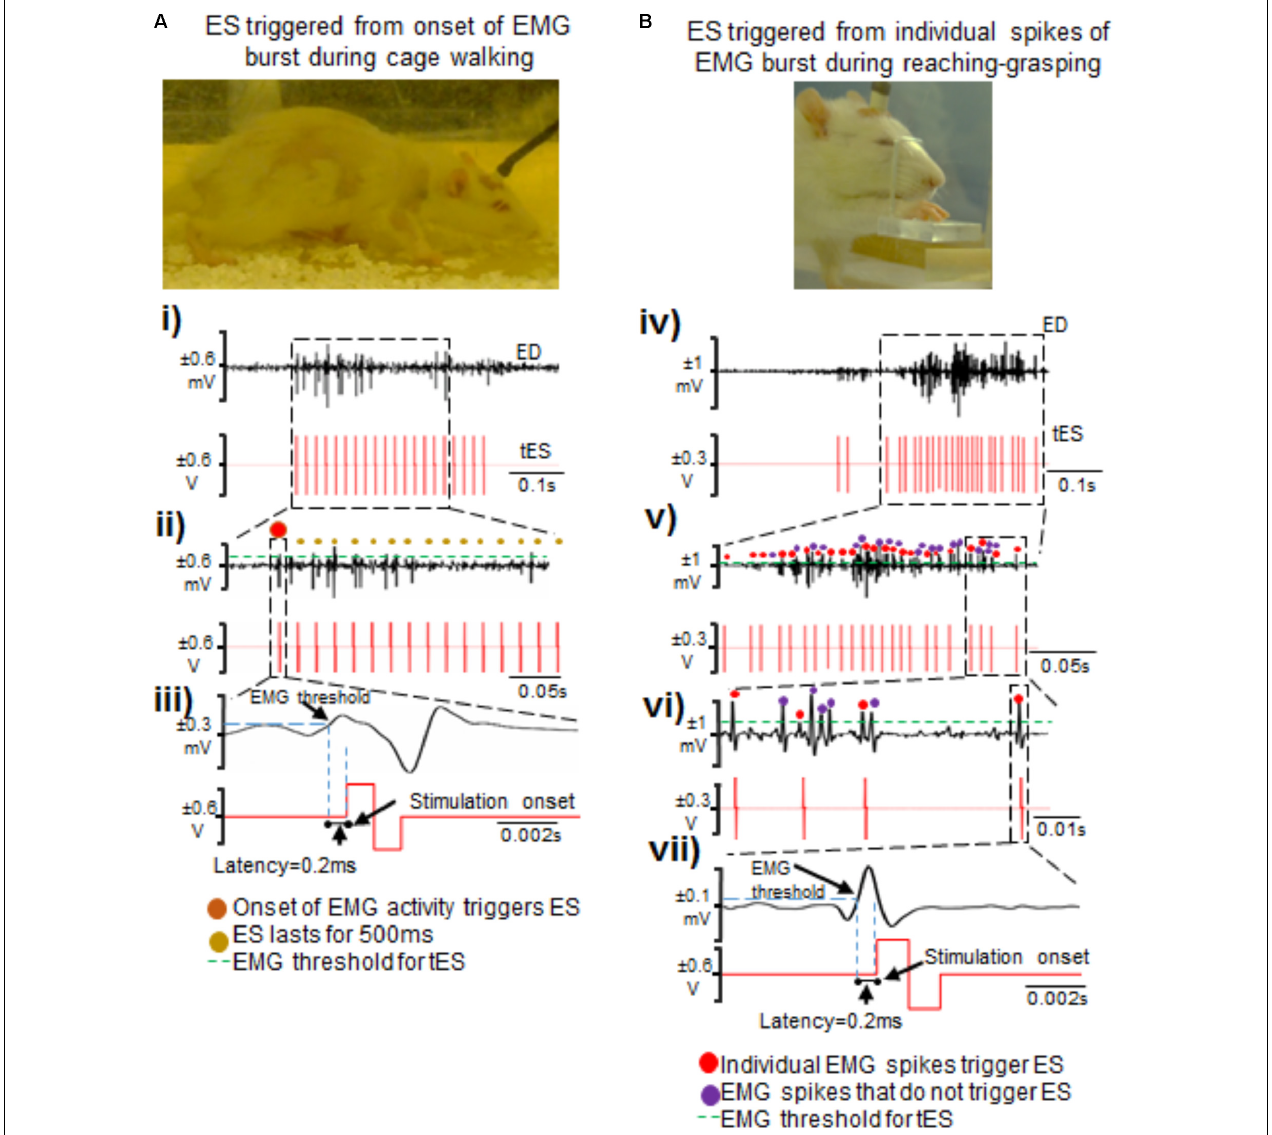
FIGURE 5 | Two methods of triggering ES from EMG signals during attempted activity. (A) Shown are standstill images of a rat receiving tES triggered from the onset of the extensor digitorum (ED) muscle bursting activity during walking in the home-cage. (i) Single ED burst during walking with corresponding stimulation train. (ii) Shown is a zoomed-in view of the EMG burst. The red dot represents the first spike that initiated the train of ES pulses (shown as red biphasic waveform). (iii) A single spike along with corresponding ES pulse triggered from that spike is zoomed to demonstrate latency for onset of stimulation pulse after the EMG spike crosses a set threshold. (B) Shown are standstill images of a rat receiving tES triggered from individual spikes (EPSPs) in an EMG burst during a reaching-grasping task. (iv) Biphasic stimulation pulses are delivered in response to individual spikes in an EMG burst that crosses a user defined threshold. (v) Zoomed-in view of the EMG signal shows individual spikes and corresponding stimulation pulses. Red dots are the spikes that triggered tES. Violet dots are the spikes that cross the user-defined threshold, but do not trigger tES because of the preset inter-stimulation interval time. (vi) Expanded view of individual spikes that triggered (red dots) or failed to trigger (violet dots) tES. In this example, an inter-stimulation interval is set to 10 ms to prevent stimulation artifacts from retriggering stimulation. (vii) Note the latency of ∼ 0.2 ms from time of spiking activity to delivery of tES, similar to what is seen in (iii)